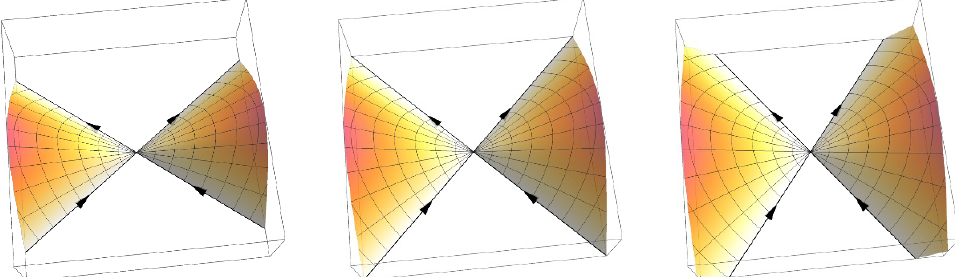
Figure 3 . Sketch of the minimal surfaces for two lines intersecting at the angles 3 (cid:25)= 8, (cid:25)= 2 and 5 (cid:25)=